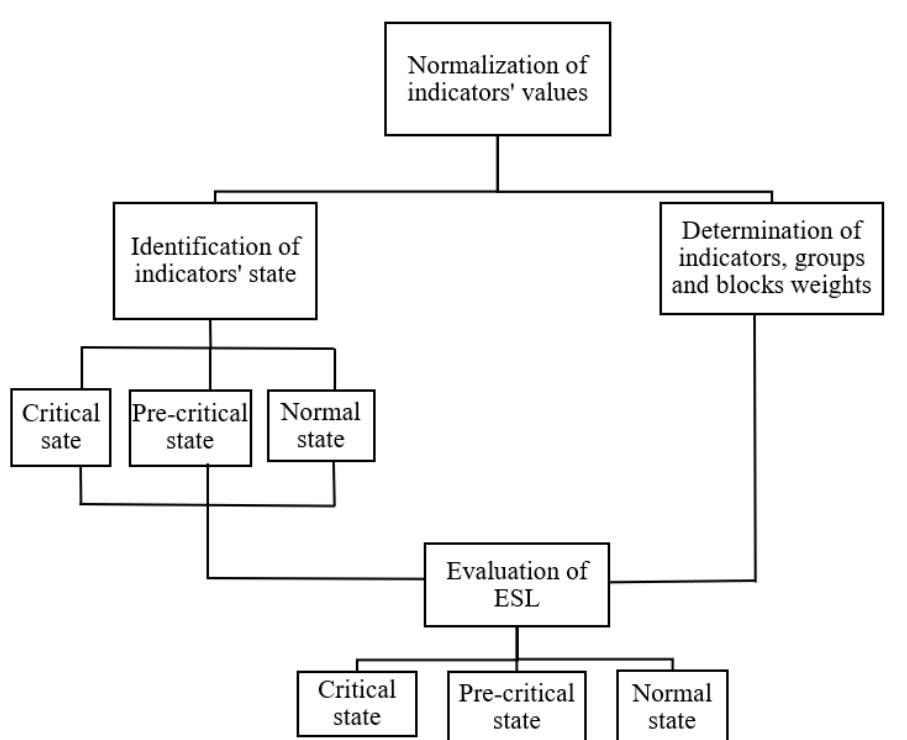
Figure 3. Assessment of energy security level. Source: own research.